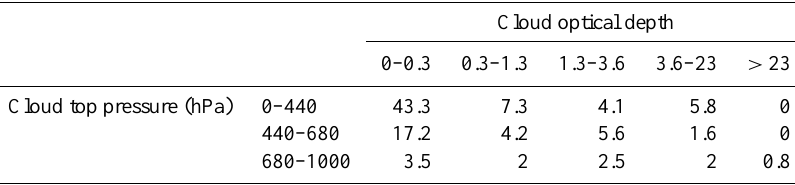
Table 3. Frequency of occurrence (%) for TES retrievals for the C categorization. There was a total of 20713 retrievals during daytime over the tropics.